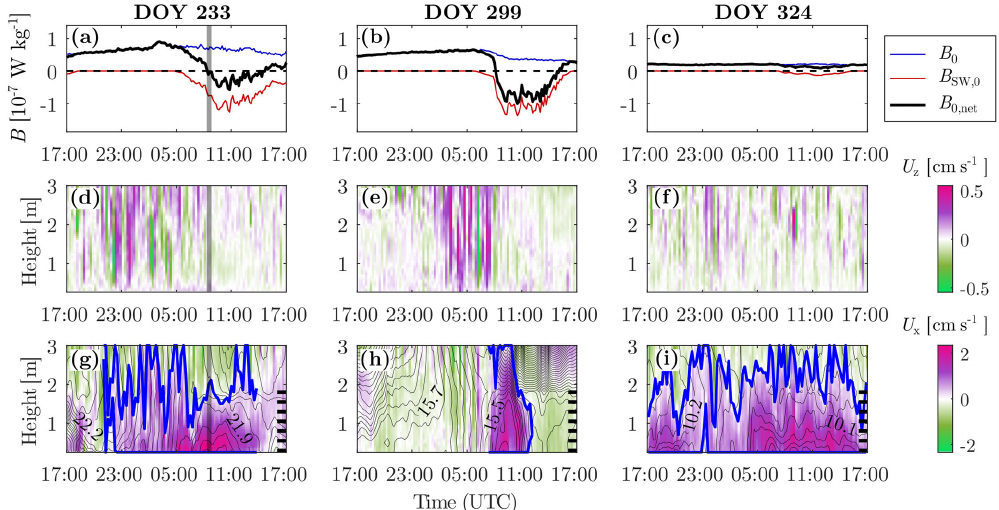
Figure B2. Three examples of TS events, with (a–c) buoyancy fluxes, (d–f) vertical velocity, and (g–i) cross-shore velocity, as in Fig. 3. (a, d, g) A long TS event on 21–22 August 2019 due to short heating phases on both days. (b, e, h) A short TS event on 26–27 October 2019 due to strong heating on both days (re-stratification). (c, f, i) Continuous flushing on 20–21 November 2019 due to continuous net cooling. See the caption of Fig. 3 for more details about each panel. The gray shaded area in panels (a) , (d) , and (g) indicates the time of the CTD transect shown in Fig.